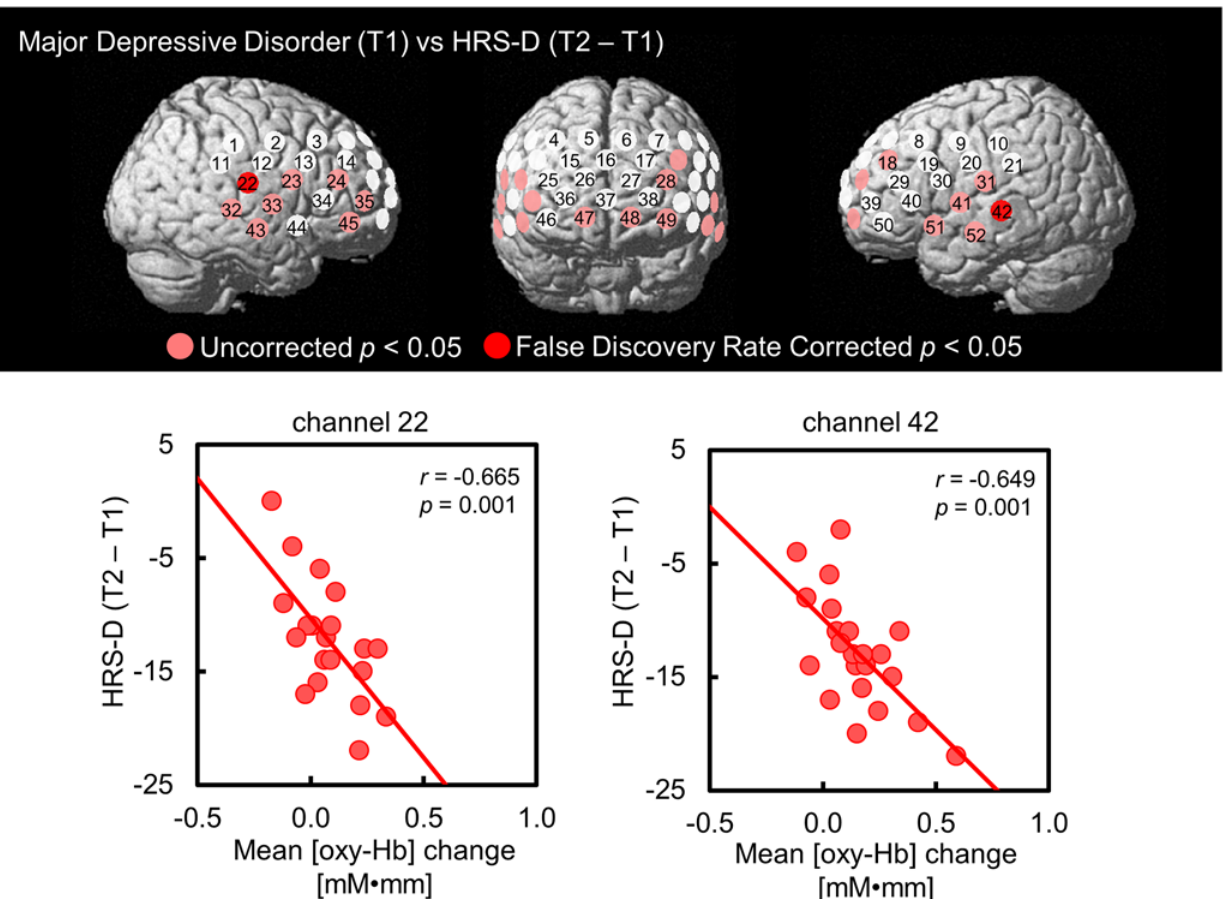
Fig 4. Correlations between mean [oxy-Hb] values and antidepressant treatment. Correlation of mean [oxy-Hb] values during VFT at T1 with changes of HRS-D scores following antidepressant treatment (T2 — T1) in MDD. T1: baseline, T2: after treatment. Above: Channels in red (ch 22 and 42) showed a significant correlation ( P < 0.05; FDR-corrected) and channels in pink also showed a significant correlation ( P < 0.05; uncorrected). Below: Scatterplots for correlations in ch 22 and 42. oxy-Hb, oxygenated haemoglobin signal; VFT, Verbal fluency task; HRS-D, 17-item Hamilton rating scale for Depression; MDD, Major depressive